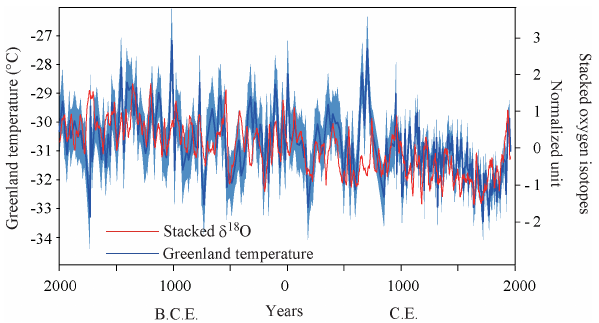
Fig. 1. Greenland temperature and stacked δ 18 O ice records over the past 4000yr. Error bands represent 1 σ (standard deviation). δ 18 O ice records from six ice cores (GISP2, GRIP, NGRIP, Dye-3, Renland, and Agassiz) in 20yr RMs (Vinther et al., 2009) were normalized as time series of mean zero and standard deviation of one, and average values were calculated (red). Greenland temperature (blue) is from Kobashi et al.